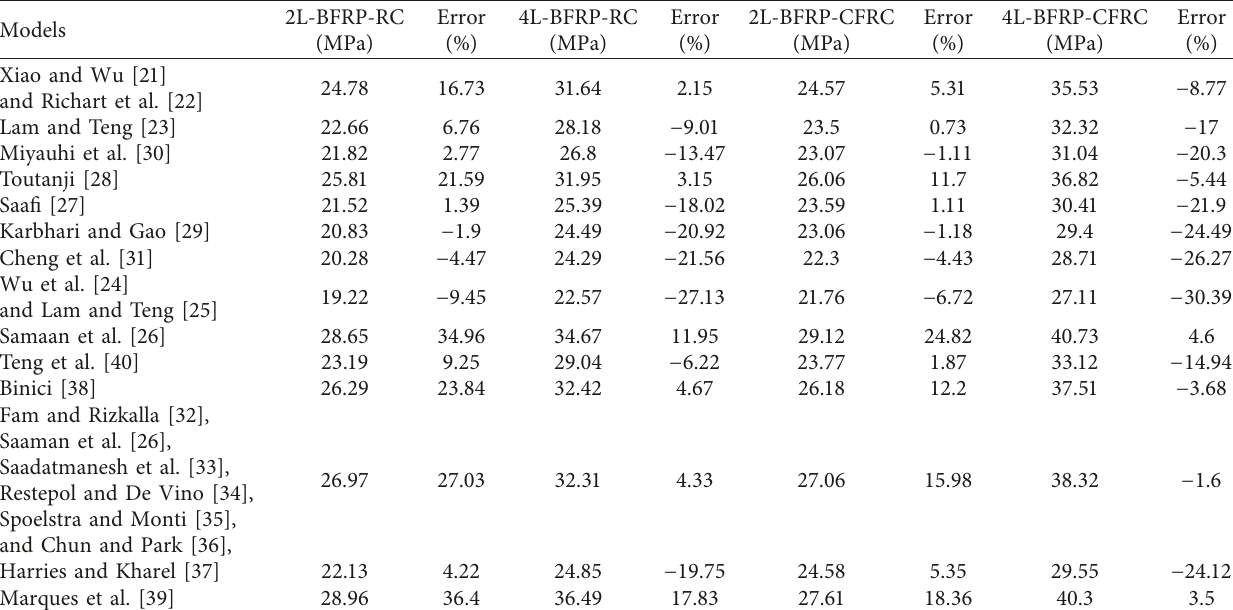
Table 6: Strength prediction of the large-size specimens by design-oriented confinement models.